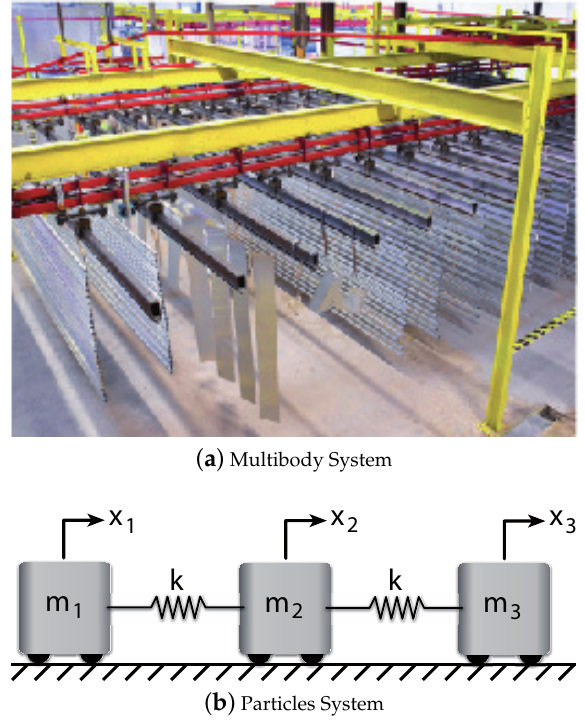
Figure 1. ( a ) Bodies that interact with each other through joints. ( b ) Particles that interact with each other throught